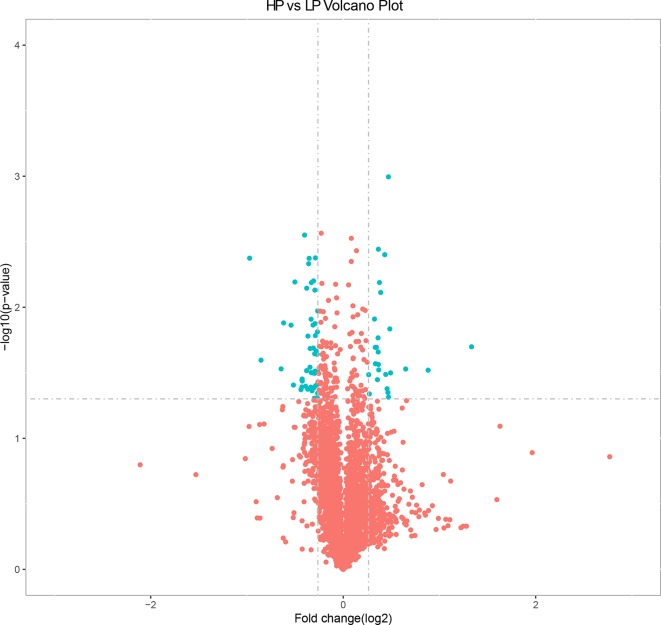
Volcano plot displaying differential expressed proteins in bovine liver tissues with proteomic analyses within two different comparison groups. The y axis corresponds to the mean expression value of log10 (p value), and the x axis displays the log2 fold change value. The blue dots represent the significantly differential expressed transcripts; the red dots represent the transcripts whose expression levels did not reach statistical significance.